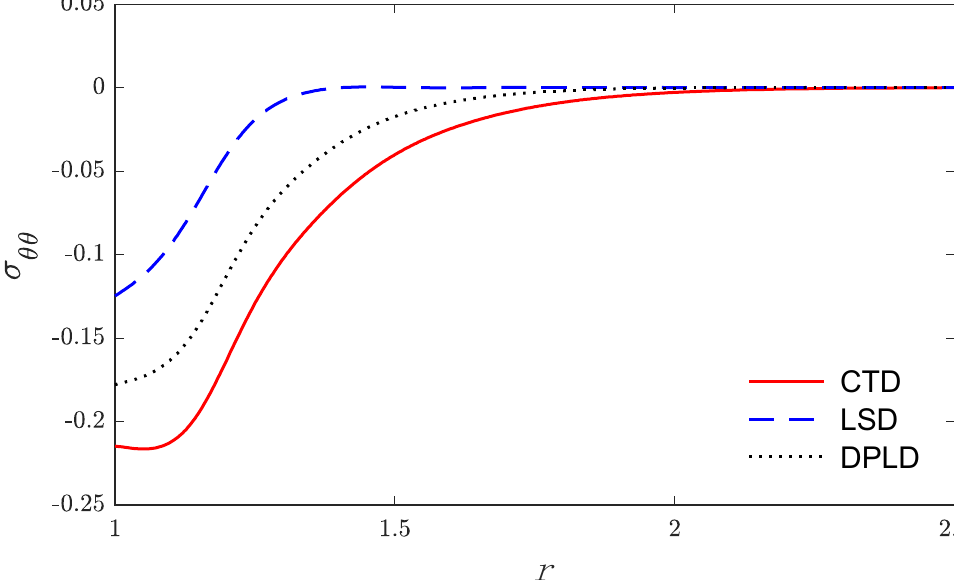
Figure 5. The shear stress variations 𝜎 (cid:3105)(cid:3105) versus the redial distance 𝑟 for three models.